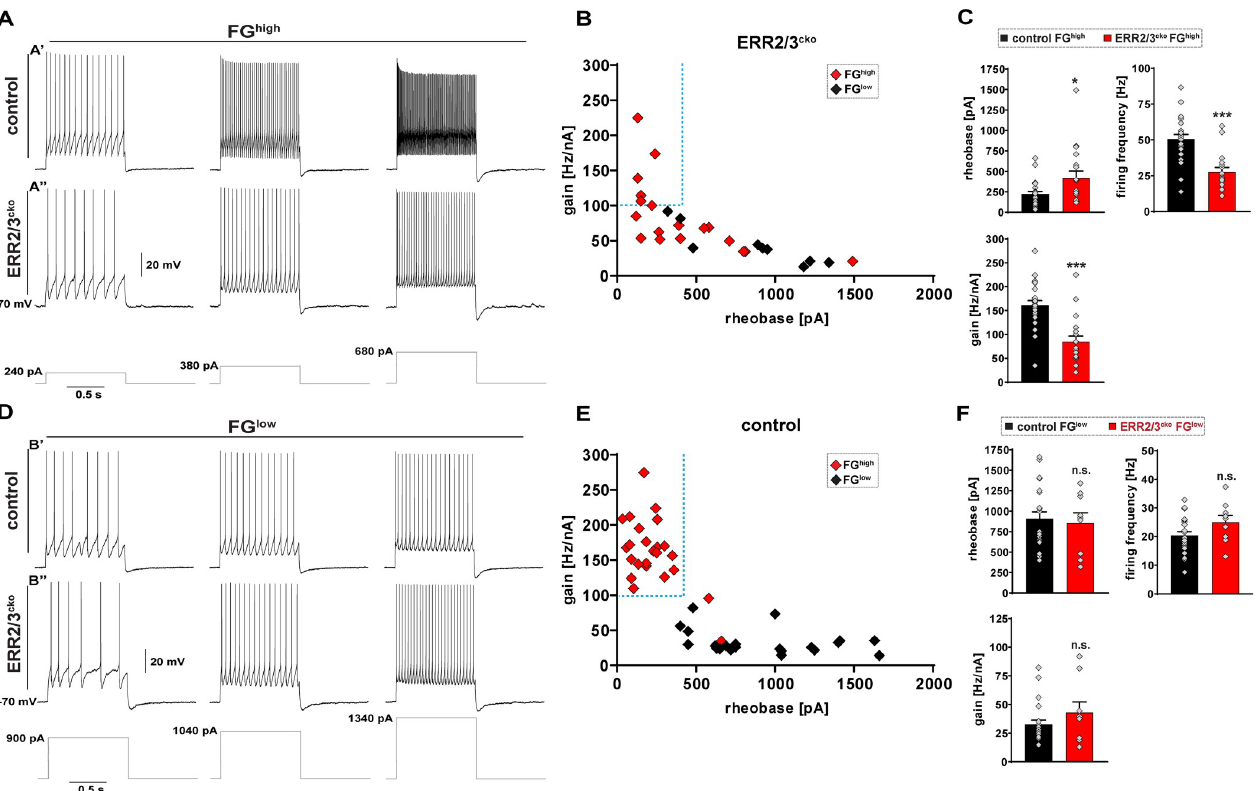
Fig 3. ERR2/3 are required for the acquisition of a gamma motor neuron biophysical signature. (A) Example traces of whole-cell patch-clamp recordings upon 240, 380, or 680 pA, 1 second square current pulses from small soma motor neurons exhibiting high levels of FG incorporation (FG high ) from control mice or ERR2/3 cko mice. Control FG high motor neurons (A’) exhibit higher firing rates compared to FG high ERR2/3 cko motor neurons (A”) and gear up their firing rates more rapidly in response to current pulses. (B) Scatter plot: lack of segregation of ERR2/3 cko FG high gamma motor neuron and ERR2/3 cko FG low alpha motor neuron electrophysiological signatures. (C) ERR2/3 cko FG high motor neurons show higher rheobase (419.72 ± 84.11), lower firing frequency (27.61 ± 3.15), and lower gain (84.01 ± 12.34) compared control FG high motor neuron rheobase (221.87 ± 31.34), firing frequency (50.65 ± 3.23), gain (161.01 ± 9.77), respectively. (D) Example traces of whole-cell patch-clamp recordings upon 900, 1,040, or 1,340 pA, 1 second square current pulses from large soma motor neurons with lower levels of FG incorporation (FG low ) from control mice or ERR2/3 cko mice. ERR2/3 cko FG high motor neurons exhibit comparable firing rates and properties to control FG low motor neurons. (E) Scatter plot: segregation of electrophysiological signatures between control FG high gamma motor neurons versus control FG low alpha motor neurons. (Note: Data are from Fig 1D). (F) No significant differences seen in ERR2/3 cko FG low alpha motor neuron subtype rheobase (855.55 ± 124.85), firing frequency (25.03 ± 3.76), and gain (43.04 ± 9.81) when compared to control FG low alpha motor neuron subtype rheobase (909.09 ± 82.11), firing frequency (20.41 ± 1.70), gain (32.64 ± 4.02), respectively (see S1 Table for details). Data are presented as mean ± SEM. n = # of neurons and N = # of mice. Statistically significant differences between FG high and FG low neurons are indicated as � p < 0.05, �� p < 0.01, ��� p < 0.001, n.s. = not significant, Student t test). Data for Fig 3B, 3C, 3E, and 3F can be found in S1